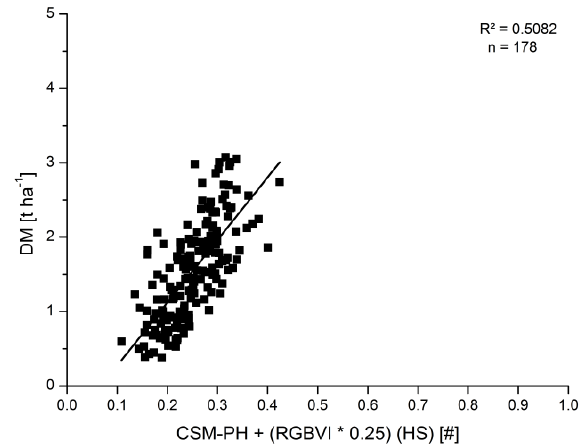
Figure 8b. Grass I-Index from hyperspectral measurements (CSM-PH aggregated with 25 % of each RGBVI value) versus dry matter (DM), G 2 & 3